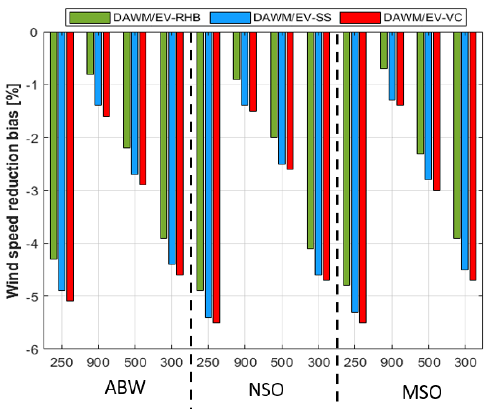
Figure A1. Averaged percentage of wind speed reduction bias (LES-Induction model) at 2.5 D upstream of each N-4 wind farms and for each induction model implemented in Openwind and coupled with DAWM the